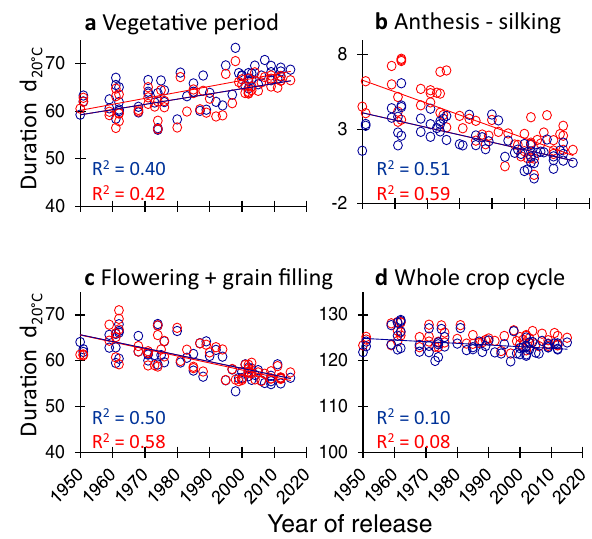
Fig. 4 Change with year of release of the phenological phase durations. a Vegetative period, from emergence to anthesis, b anthesis-silking, from anthesis to silk extrusion from the ear, c fl owering + grain fi lling, from anthesis to maturity, d whole crop cycle, from emergence to maturity. Field experiments i, j, l and m. Blue symbols, experiments with soil water potential higher than − 0.1 MPa throughout the plant cycle; red symbols, experiments with water de fi cit. One dot per genotype× soil water scenario (BLUEs). Regression lines are drawn when slopes are signi fi cant ( p < 0.01). For better intuition, panels a , c , d are presented with the same scale. Source data and p -values in Supplementary data